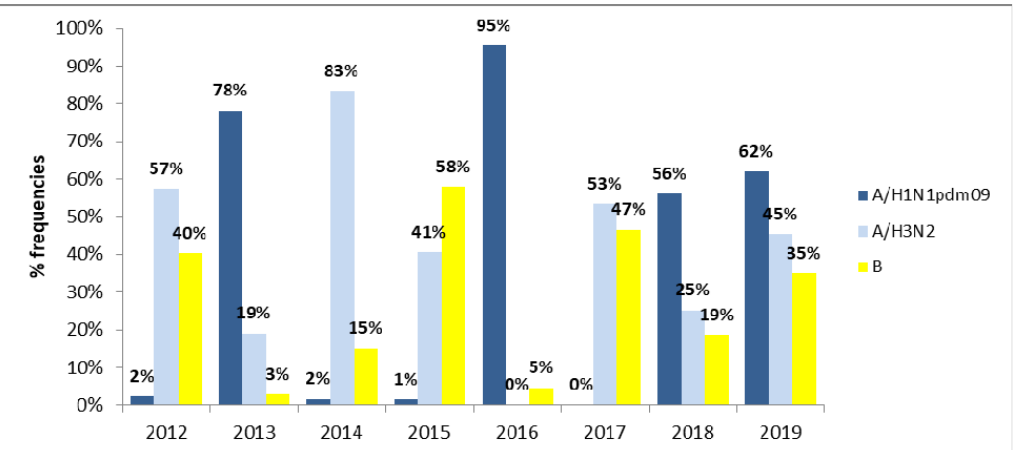
Figure 2. Incidence of influenza A and B viruses identified from clinical samples in Uruguay during 2012 to 2019. The year distribution of the influenza viruses, including A (H1N1pdm09) (blue color), A(H3N2) (light blue) and influenza B (yellow color) activity.